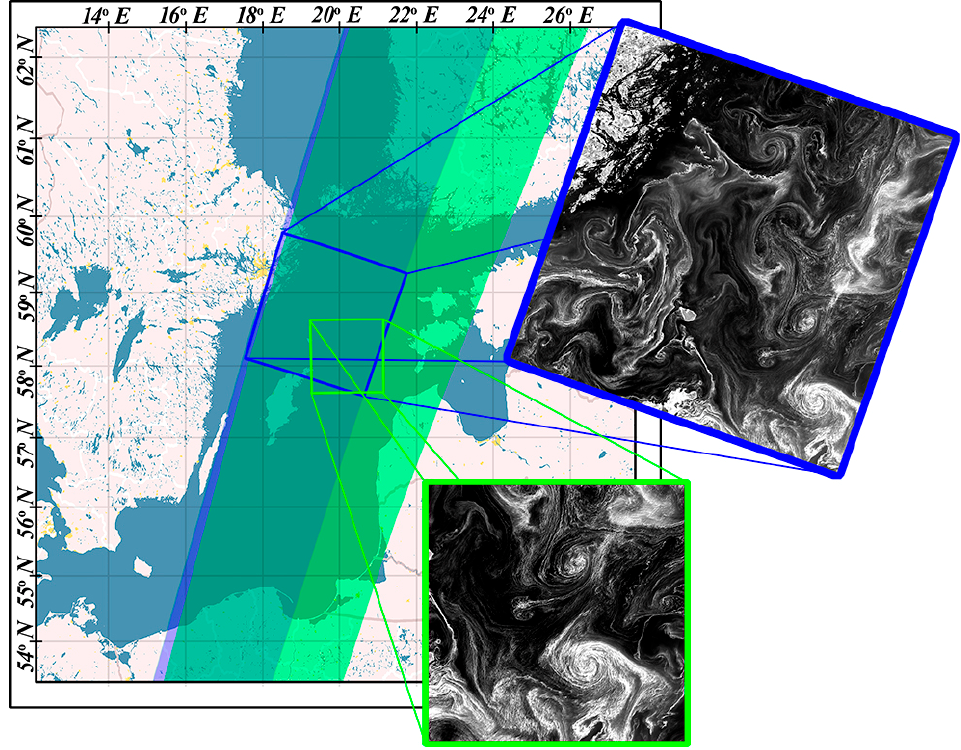
Figure 1. Map of satellite imaging of the Baltic Sea on 25 July 2018; blue area: Landsat-8 OLI, green area: Sentinel 2A MSI. The fragments show the scenes in the green band.